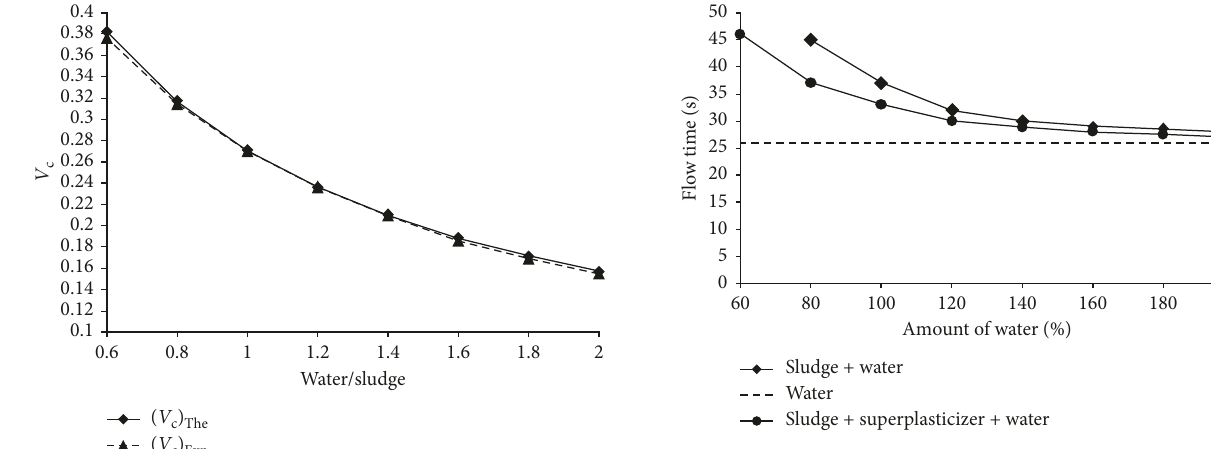
Figure 7: Marsh funnel flow time of different